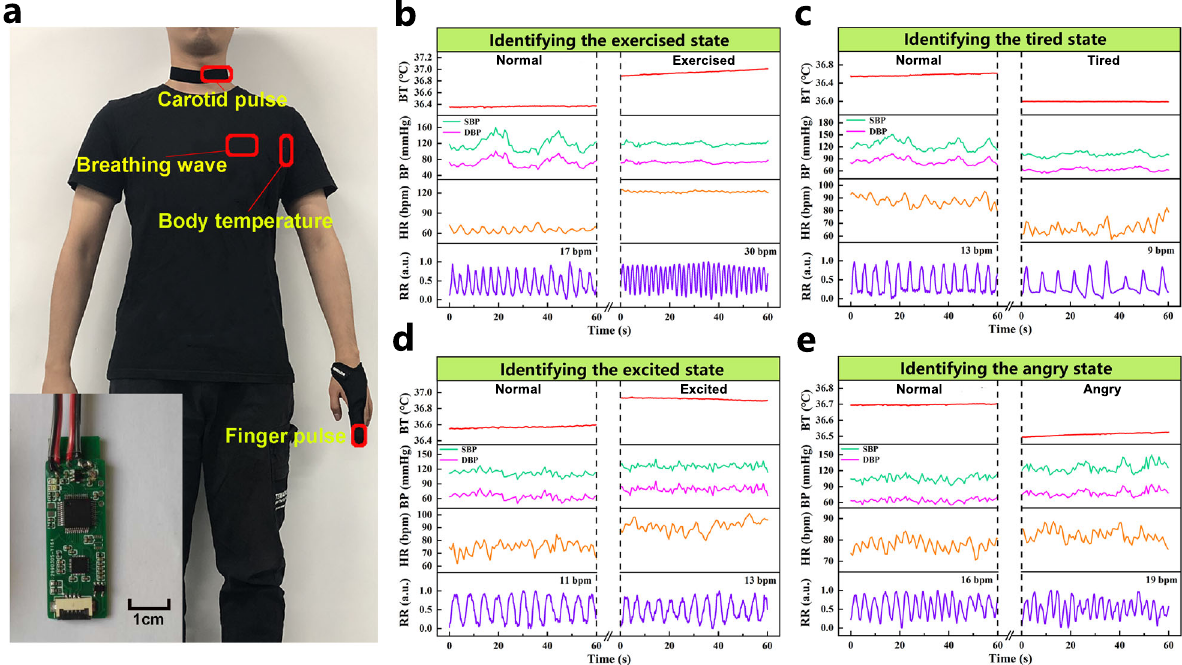
Fig. 5 Identi fi cation of the human body states. a Photograph of the wearable equipment in which four fl exible sensors are used to simultaneously acquire four vital signs from the tester: body temperature (BT), blood pressure (BP), heart rate (HR), and respiratory rate (RR). Inset: the Bluetooth acquisition board. b – e Four vital signs change for the exercise, tired, excited and angry states, respectively.